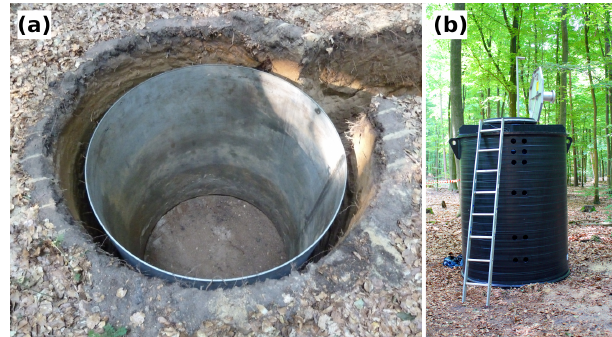
Figure 1. Photographs of (a) the lysimeter vessels used to drill the hole for the subsoil observatories, and (b) the polyethylene shaft used as the subsoil